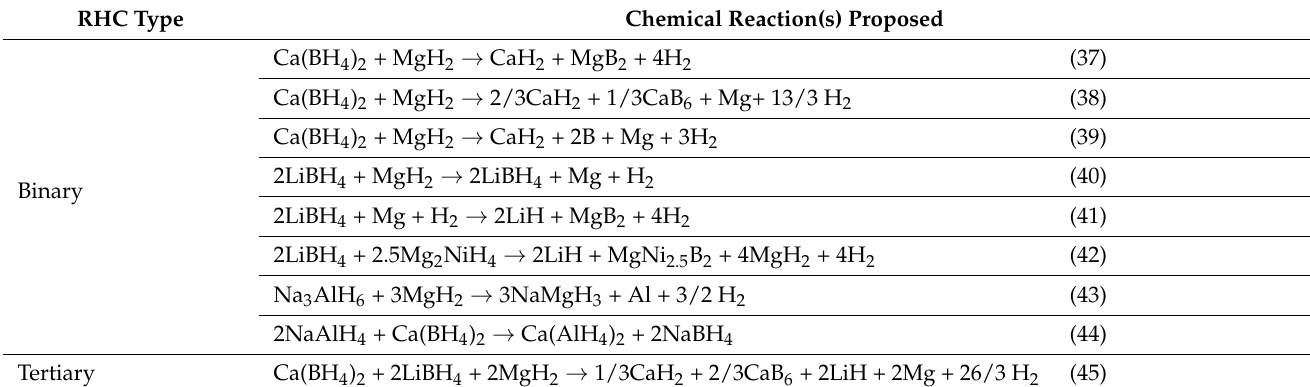
Table 4. Examples of proposed chemical reactions in binary and tertiary